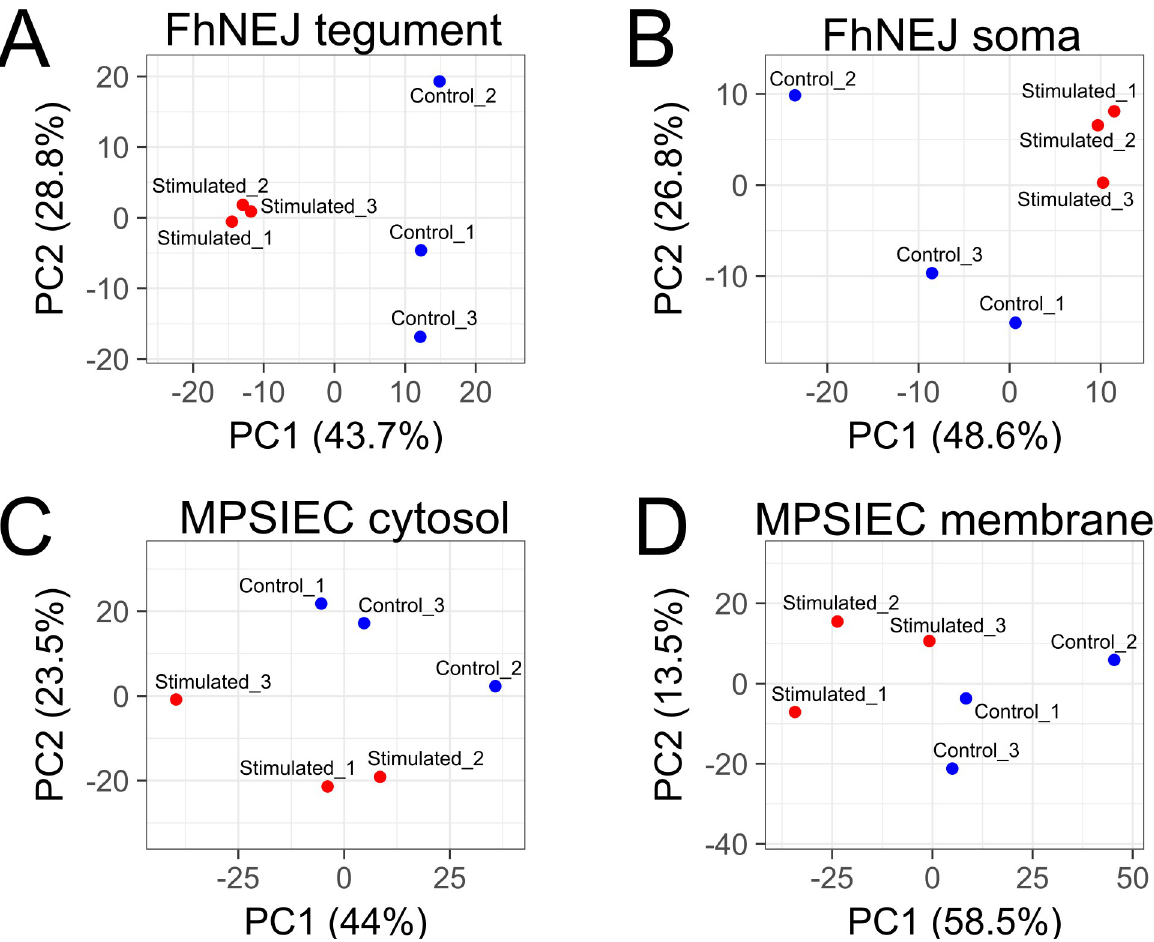
Fig 2. Principal Component Analysis (PCA) of each group of samples analysed in the study. PCA analyses of FhNEJ detergent-soluble extract enriched with tegument (FhNEJ tegument; A), FhNEJ somatic (B), MPSIEC cytosol (C) and MPSIEC membrane (D) protein extracts. Blue dots represent the three control replicates (incubated alone for 3h; control) whereas red dots represent the three replicates co-incubated for 3h (stimulated). The percentage of variance explained by each principal component (PC) is indicated on its corresponding axis.